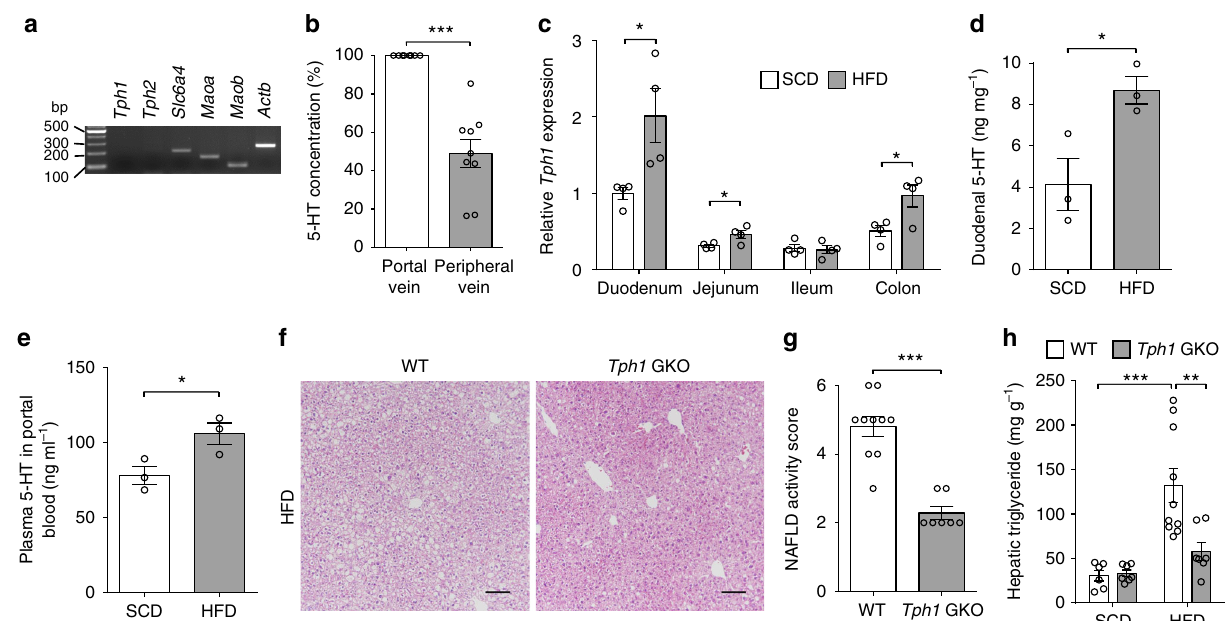
Fig. 1 Gut-derived 5-HT regulates HFD-induced hepatic steatosis. a mRNA expression of genes involved in 5-HT metabolism as assessed by RT-PCR in liver from 8-week-old C57BL/6J mice. b Plasma 5-HT concentrations of portal blood and peripheral blood in humans. Portal blood concentration set as 100%; n = 9 per group. c – e The 12-week-old male C57BL/6J mice were fed standard chow diet (SCD) or high-fat diet (HFD) for 8 weeks. c Tph1 mRNA expression in the duodenum, jejunum, ileum, and colon as assessed by qRT-PCR; n = 4 per group. d Duodenal 5-HT levels; n = 3 per group. e Plasma 5-HT levels in portal blood; n = 3 per group. f – h The 12-week-old WT and Tph1 GKO mice were fed SCD or HFD for 8 weeks. f Representative liver histology by hematoxylin and eosin (H&E) staining from HFD-fed WT and Tph1 GKO mice. Scale bars, 100 μ m. g Nonalcoholic fatty liver disease activity score (NAS) of HFD-fed WT and Tph1 GKO mice; n = 7 – 10 per group. h Hepatic triglyceride levels; n = 6 – 10 per group. Data are expressed as the means± SEM. * P < 0.5, ** P < 0.01, *** P < 0.001, Student ’ s t -test ( b – e , g ) or one-way ANOVA with post hoc Tukey ’ s test ( h